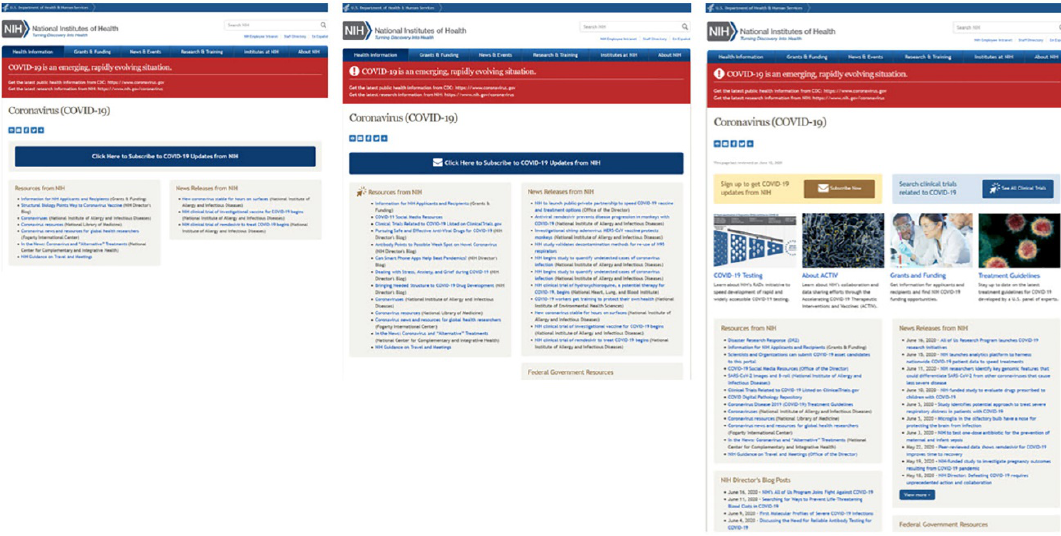
Figure 3 Screen captures of the National Institutes of Health (NIH) Coronavirus (COVID-19) website, March–June 2020